Question: What visual encoding does this figure use to show its data?
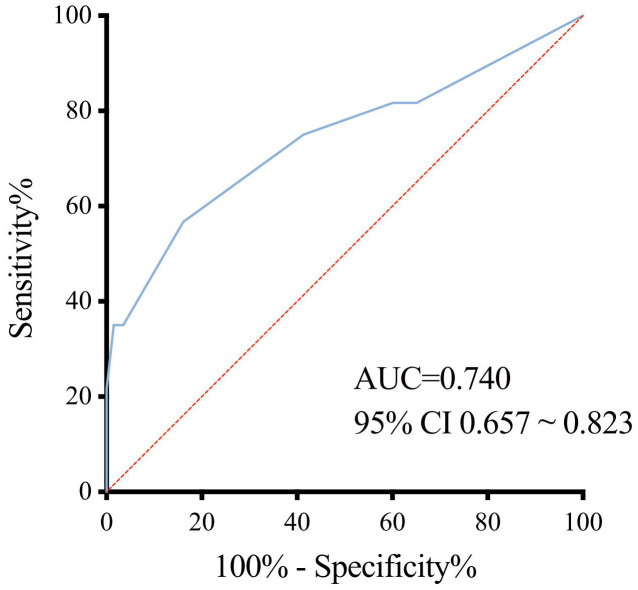
Answer: line